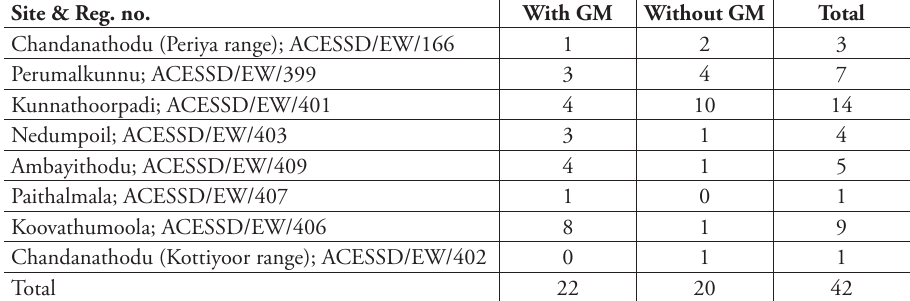
Table 3. Number of Drawida modesta specimens with and without genital markings (GM). Site & Reg.